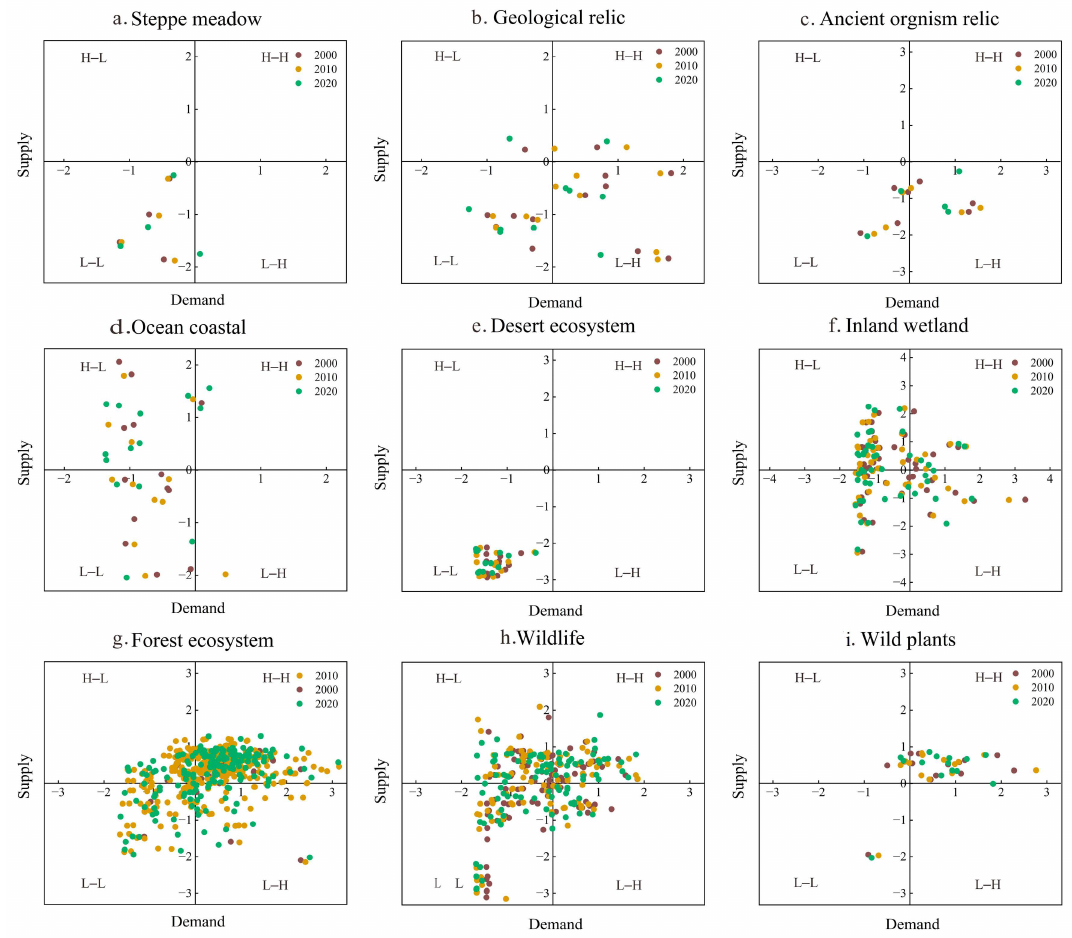
Figure 5. Ecosystem service supply and demand matching in different types of nature reserves from 2000 to 2020.